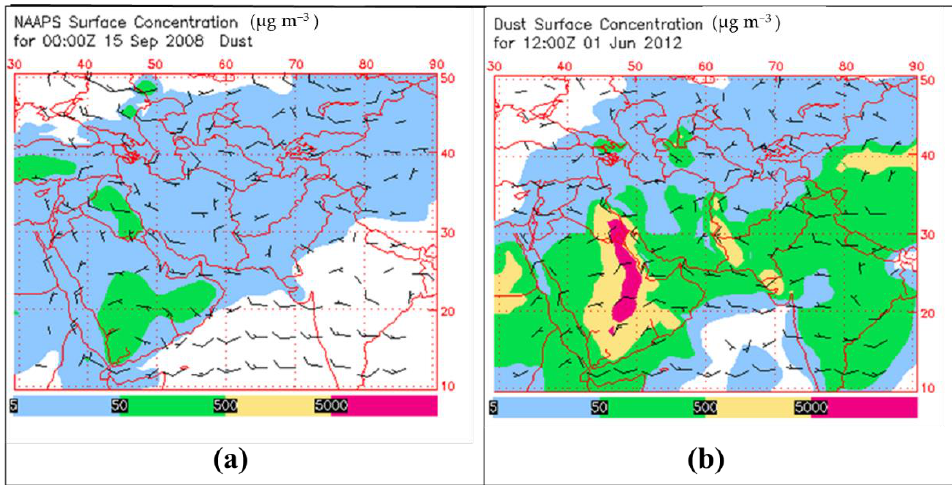
Figure 12. Surface dust concentration and wind direction from the NAAPS model at ( a ) 00 UTC on 15 September 2008, ( b ) 12 UTC on 1 June 2012.